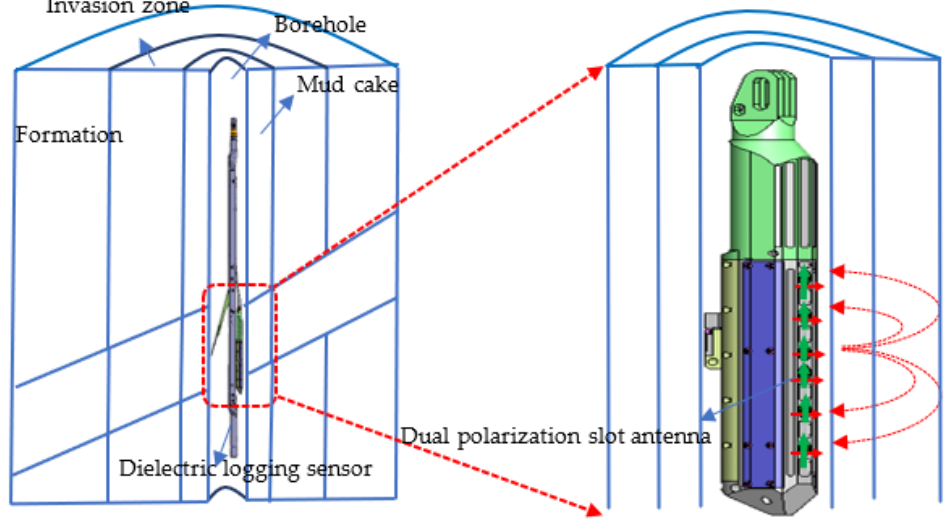
Figure 1. Schematic diagram of dielectric logging sensor.